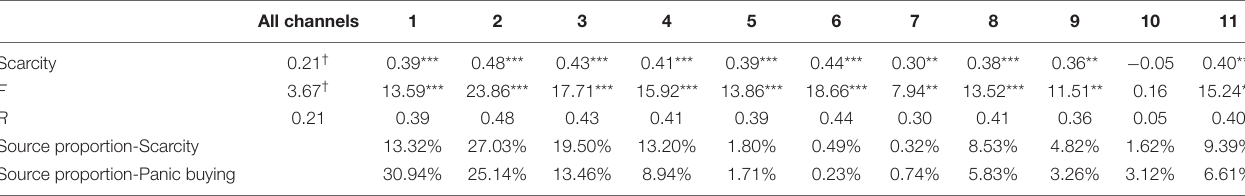
TABLE 1 | Summary of regression analysis of panic buying to scarcity for different channels ( N = 80). All